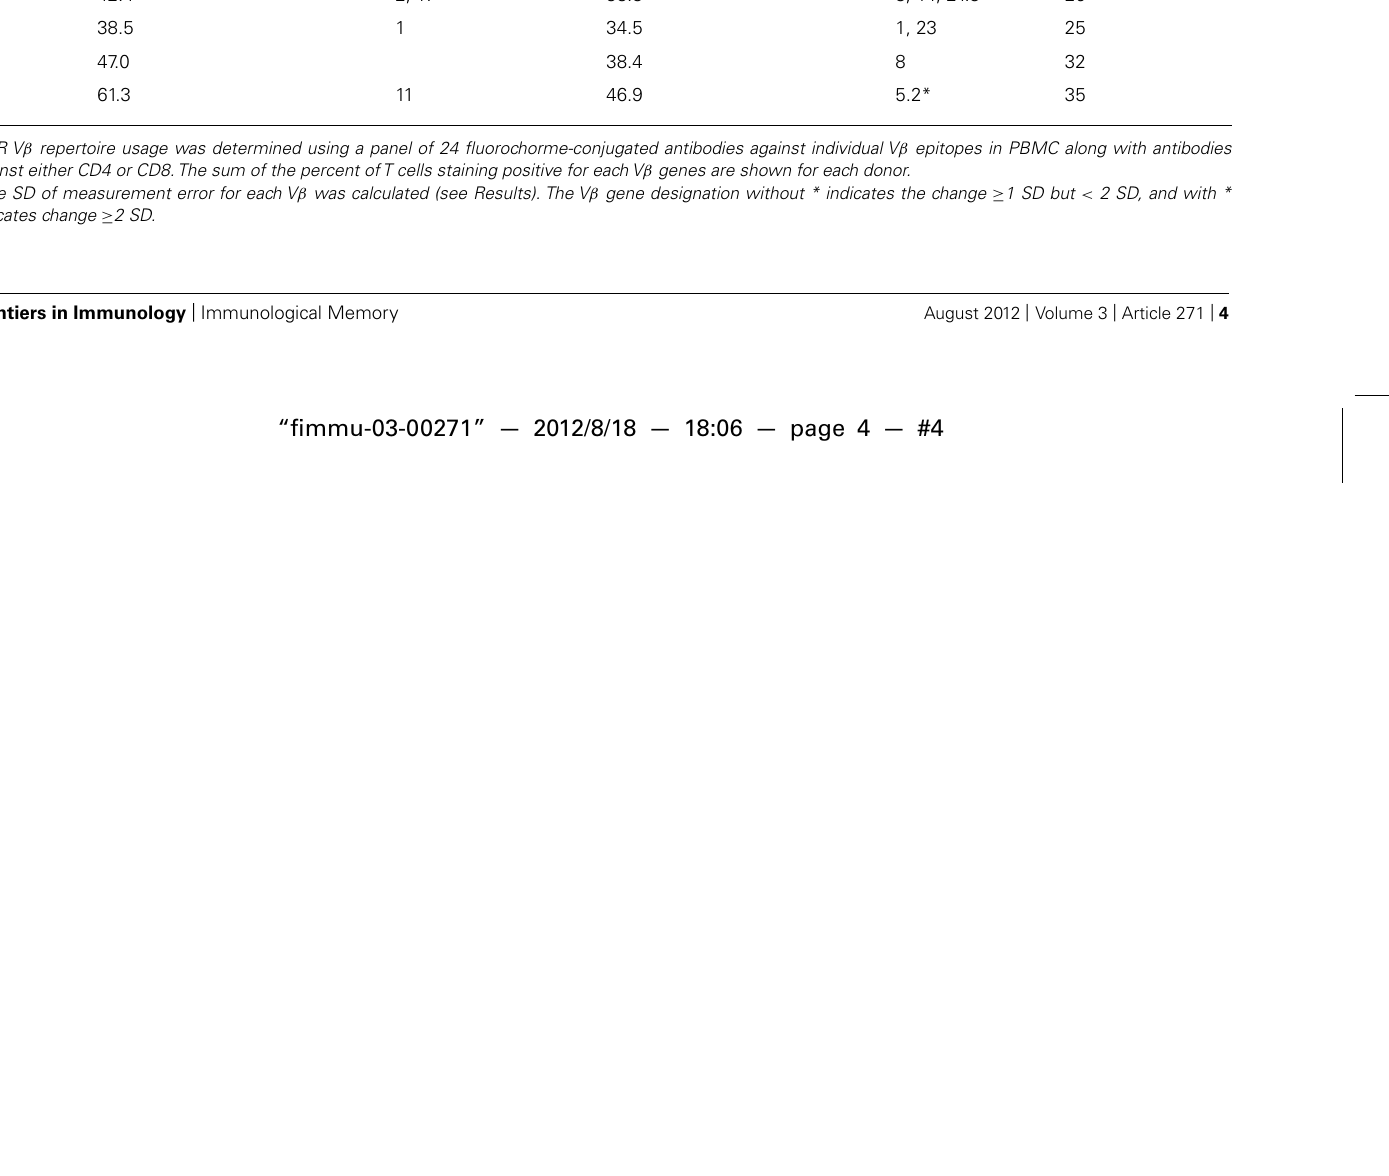
complete blood count test. Cell samples were collected at different times from each donor. For simplicity, 0 on the abscissa was the first sample collected from each donor which does not necessarily denote the first donation.Young donors are shown on the left and middle-aged donors on the right.